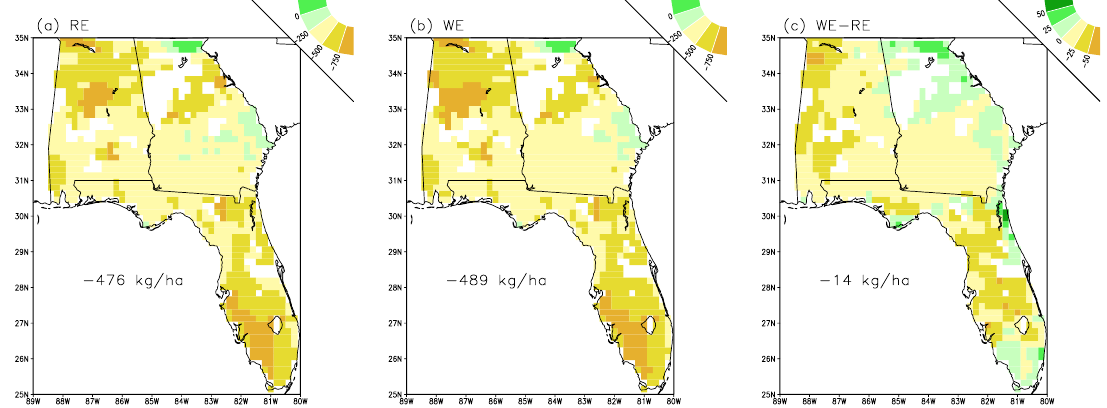
Figure 4. Multi-model ensembles of maize dry matter yield differences between future and current NARCCAP runs from Figure 3; ( a ) the regular ensemble, ( b ) the weighted ensemble, and ( c ) their difference. Unit is of kg ha −1 . Area averaged values are shown.